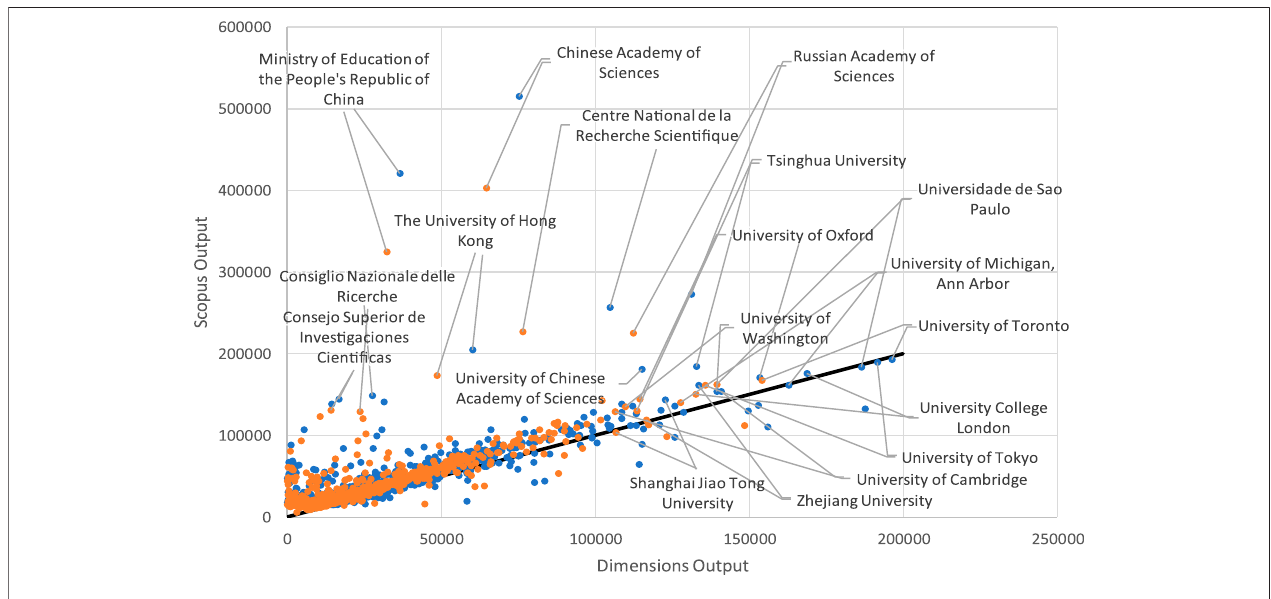
FIGURE 2 | Scatter plot of the total and matched Dimensions/Scopus output by institution.